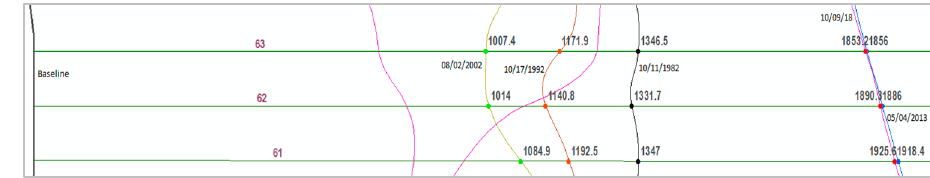
Figure 7. Transects 61, 62, and 63 of Segment A. Table 4. Total change in shoreline